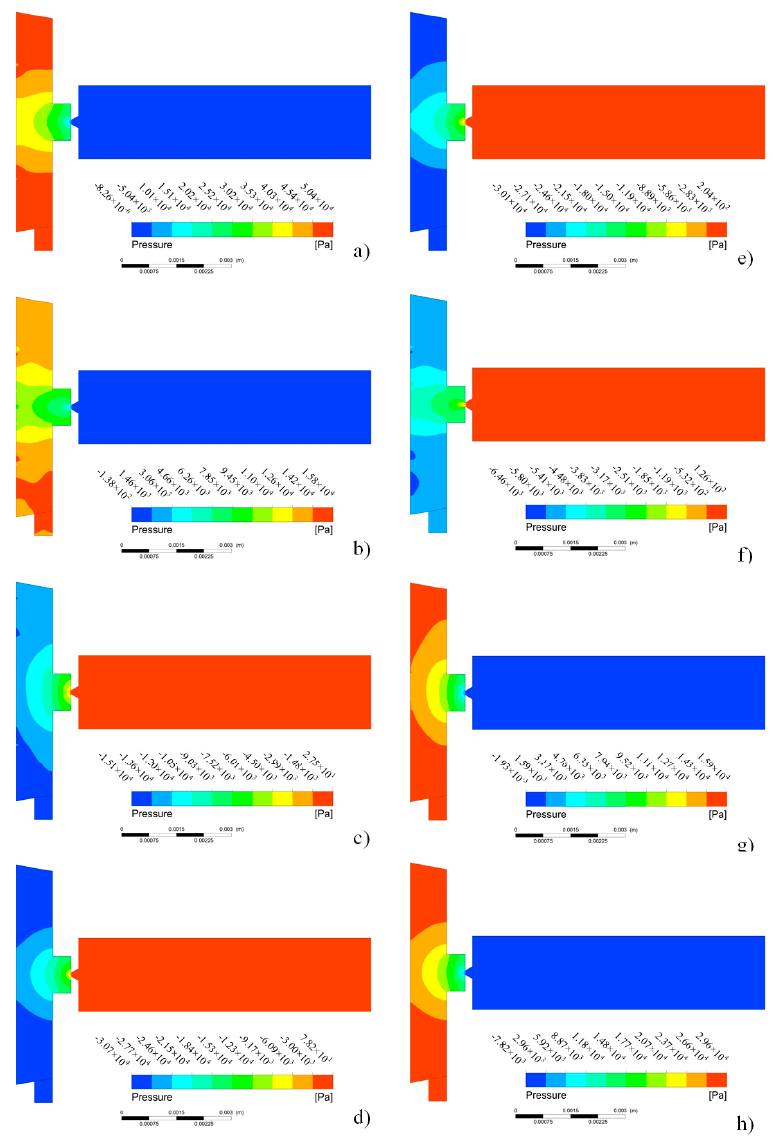
Figure 4. The pressure distribution at different timepoints: ( a ) 0.12 T ; ( b ) 0.25 T ; ( c ) 0.38 T ; ( d ) 0.5 T ; ( e ) 0.64 T ; ( f ) 0. 75 T ; ( g ) 0.88 T ; ( h ) 1 T.